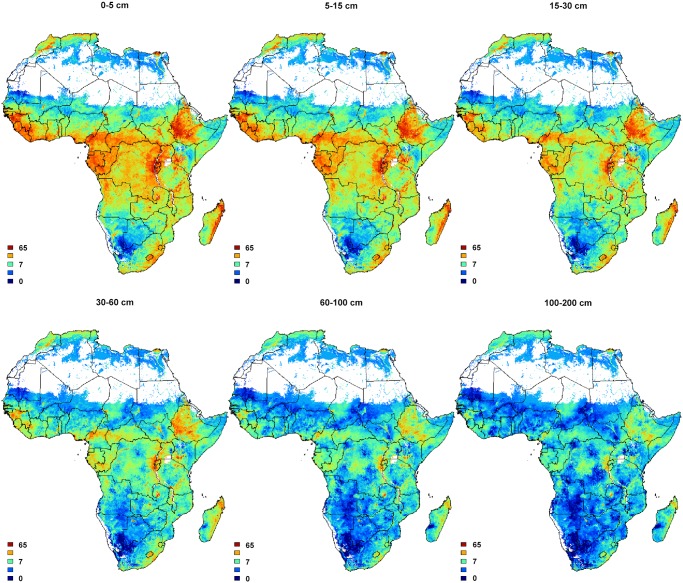
Soil organic carbon content in permilles predicted using 3D random forests RK at six standard depths.White pixels indicate excluded areas (water bodies and deserts).